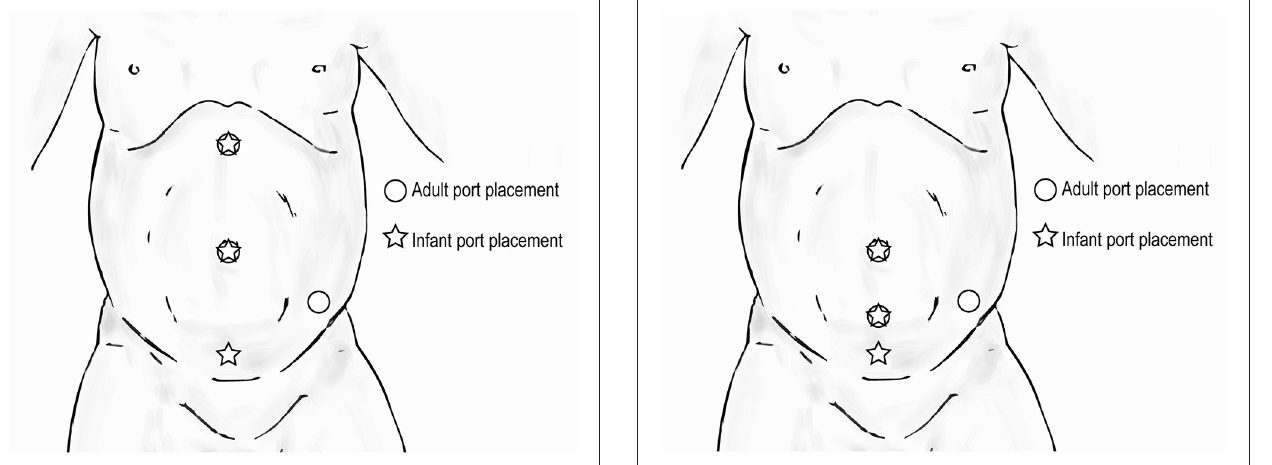
FIGURE 9 | Trocar positioning for upper urinary tract surgery in infants ( ) compared to that for adults ( ).